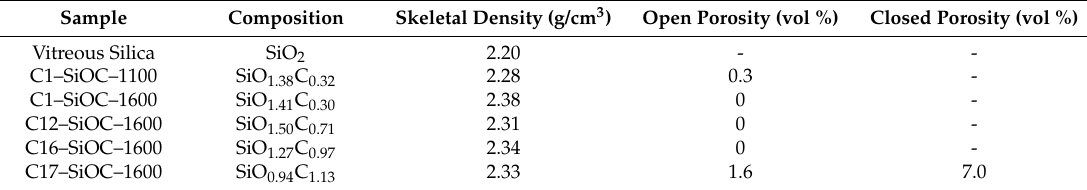
Table 3. Skeletal density and volume fractions of porosity in the SiOC samples investigated in this study. The density of silica is taken from Renlund et al. [13] and indicated for the sake of comparison. Sample Composition Skeletal Density (g/cm 3 ) Open Porosity (vol %) Closed Porosity (vol %) Vitreous